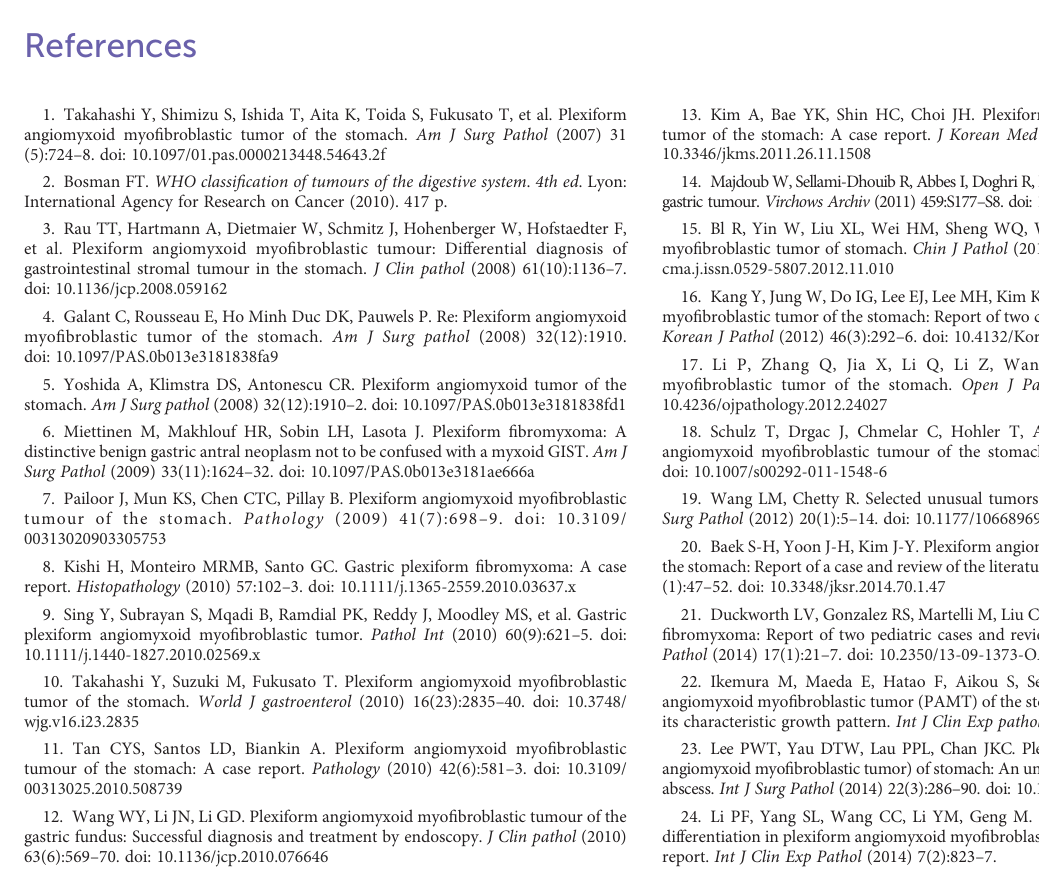
Characteristics of studies included in the